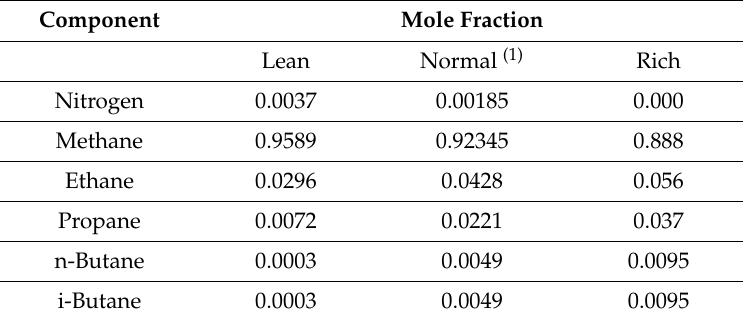
Table 2. Di ff erent feed natural gas compositions